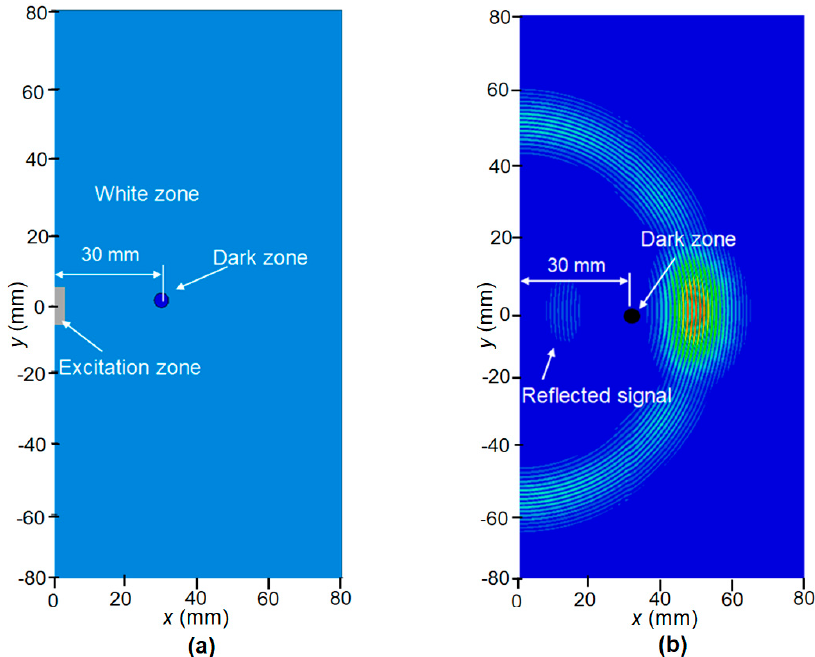
Figure 10. The sample of the mica paper with circular non-uniformity ( a ) and the snapshot of the spatial distribution of the ultrasonic pulsed field at the time instant 225 μ s ( b ).